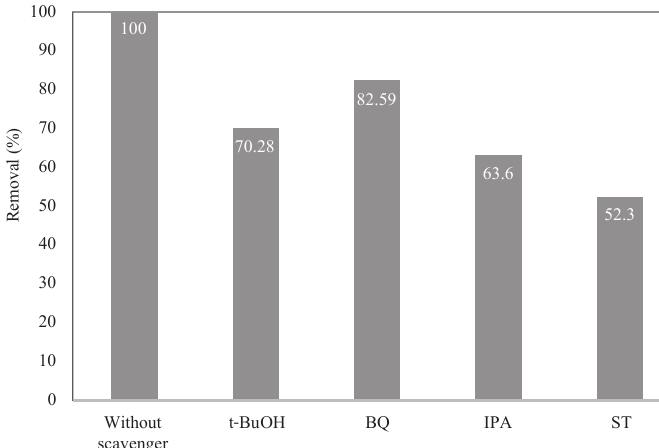
Fig. 6 – Comparison of the effect of different scavengers on the performance of persulfate-assisted EK remediation of pyrene contaminated soil in selected